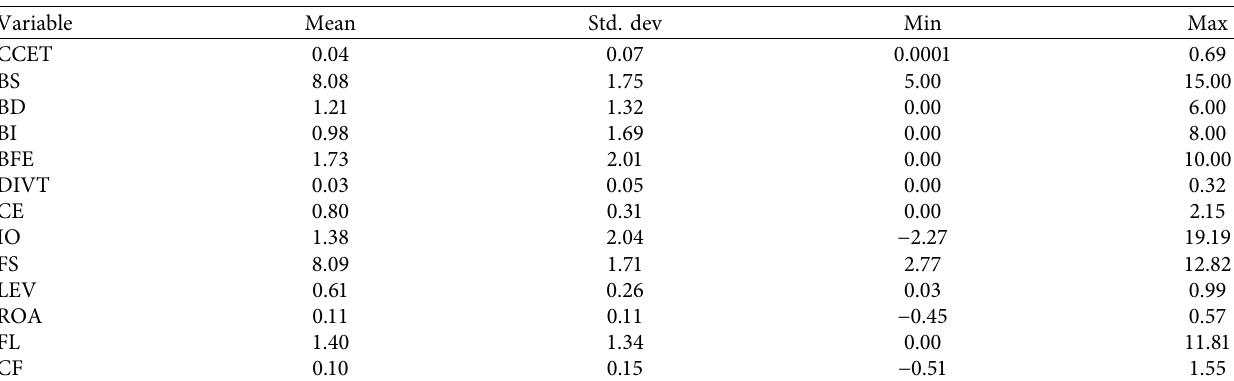
Figure 2: Decomposition of financial expertise in Pakistani listed family firms. Table 2: Summary